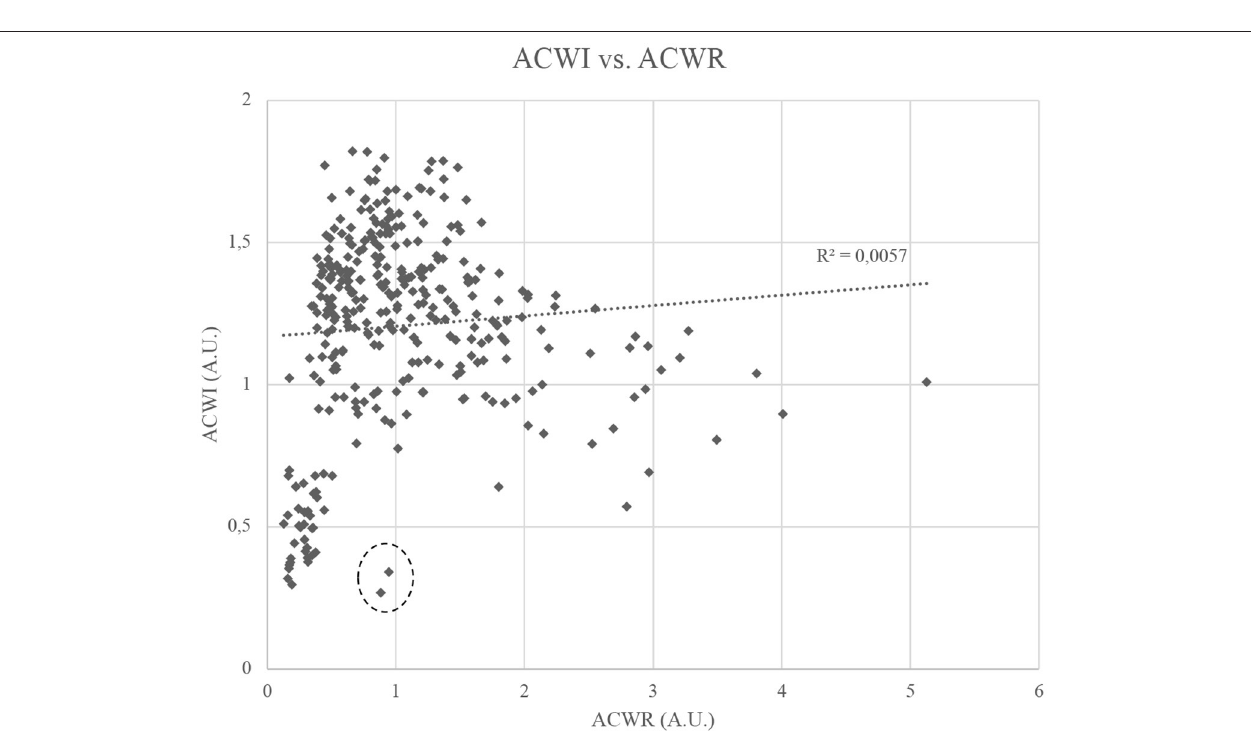
FIGURE 8 | Comparison between Acute:Chronic Workload Ratio (exponentially weighted moving average) and Acute:Chronic Workload Index. A.U., Arbitrary units.